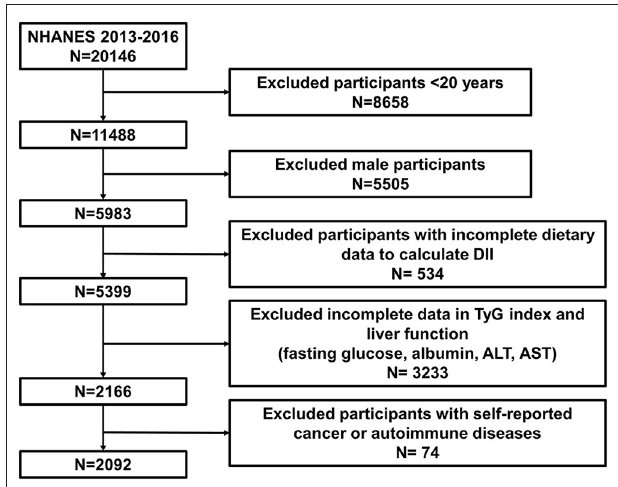
FIGURE 1 | Flow diagram of sample selection from NHANES